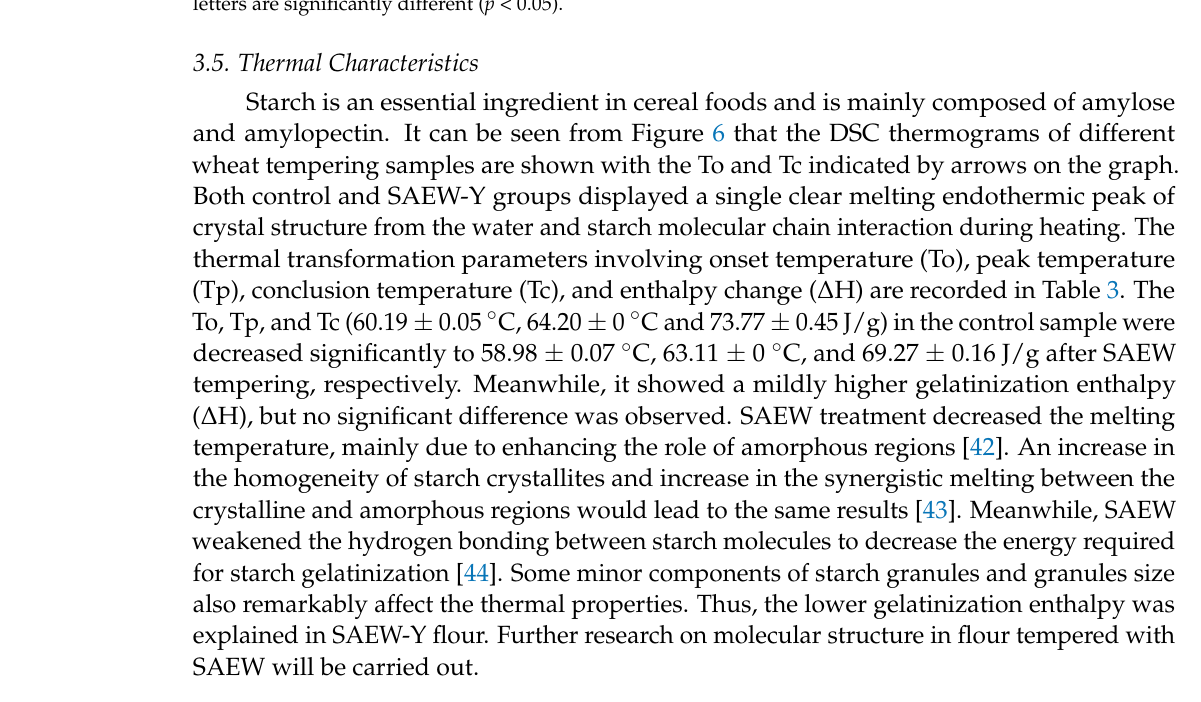
Table 3. Pasting parameters and thermal properties of the control and SAEW tempering flour sam- ples.